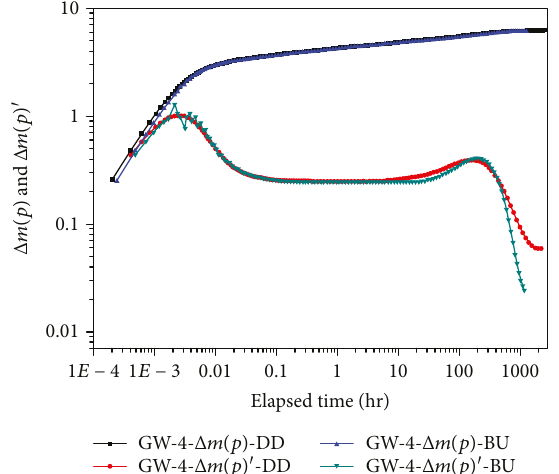
Figure 20: The log-log plot of the pressure response in gas-water reservoir with P and constant pressure boundary. It shows that c the pressure derivative with capillary pressure goes up more than that without capillary pressure in transition zone.